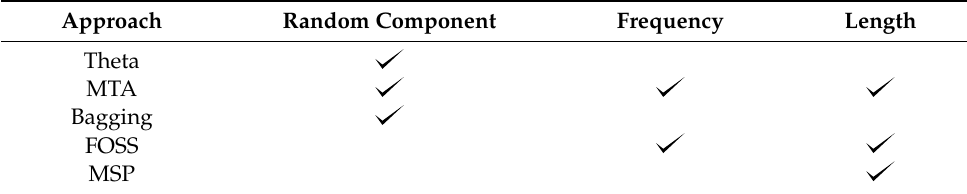
Table 1. How does extraction of the information work?